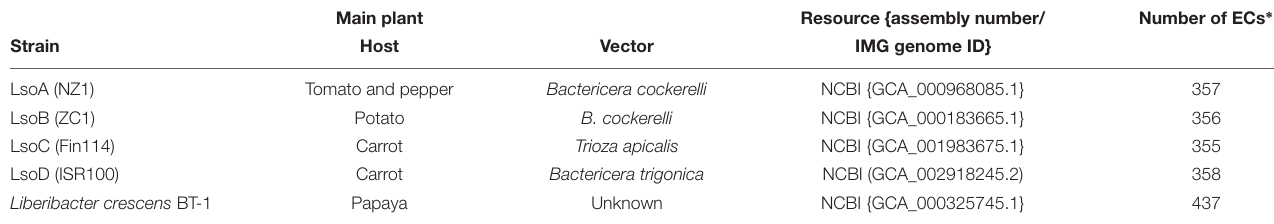
TABLE 1 | Genome list of obligate and facultative strains of Candidatus Liberibacter. Main